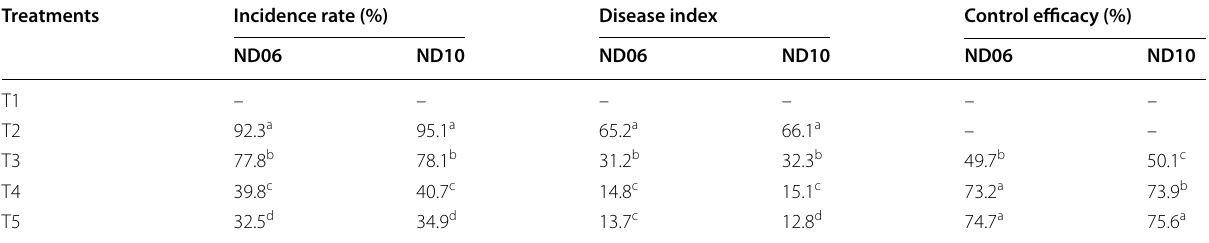
T1: A blank solution without fungus ( M. oryzae ) and endophytic bacteria; T2: A mixture of LB medium only and conidial suspension (5 added with 0.025% Tween 20; T3: A mixture of the fungicide tricyclazole (750 μg/mL) and conidial suspension added with 0.025% Tween 20; T4: A mixture of culture broth from 3-day-old cultures (10%, v/v) and conidial suspension amended with 0.025% Tween 20; T5: Rice seeds were germinated in the 3-day-old culture broth of selected strains for 24 h. After rising with autoclaved water, the geminated seeds were planted in a pot. The seedlings at the five-leaf stage were sprayed with conidial